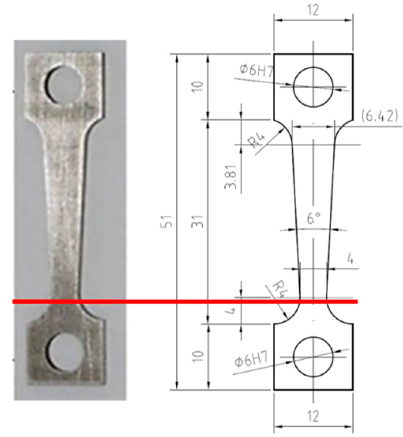
Figure 1. The photo and scheme of the flat tapered specimen used for testing in LBE with main dimensions in mm (red line is a place of rupture).